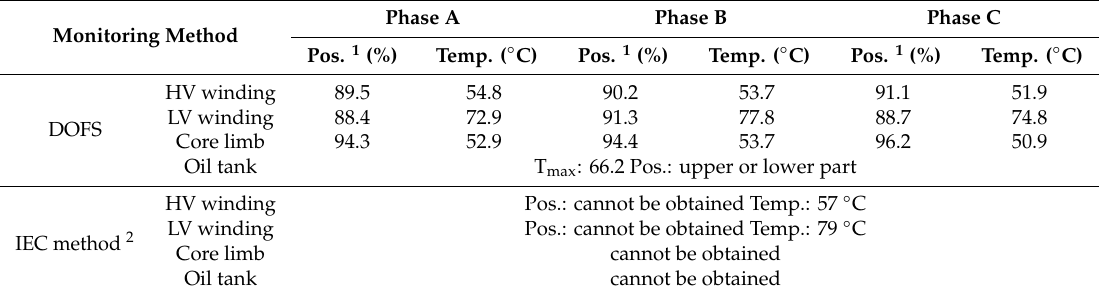
Table 2. Hotspot detecting results compared with the IEC calculation.